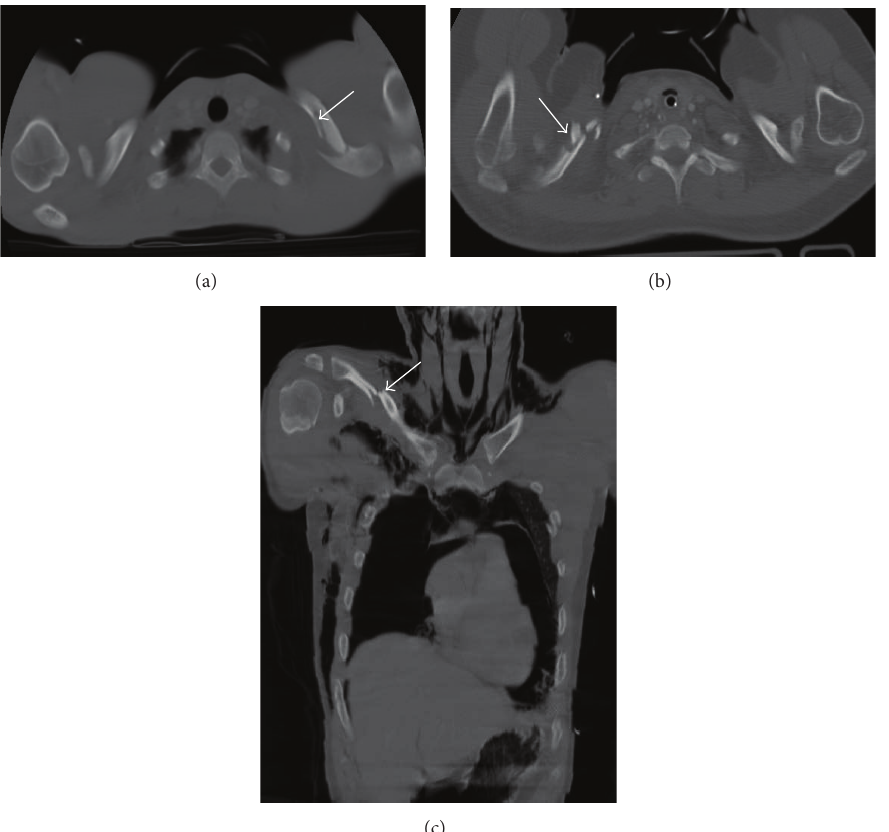
Figure 15: Three cases of clavicle fractures. Axial MDCT reconstruction in bone window ((a), (b)) and coronal reconstruction in bone window (c). A two-fracture line is seen in the left clavicle (a); a comminuted fracture is seen in the right clavicle, with multiple fragments (b); and a middle third fracture with dislocation is seen in the right clavicle (c). In (c) there are associated left anterior costal arc fracture, right pneumothorax, pneumomediastinum, and subcutaneous emphysema.